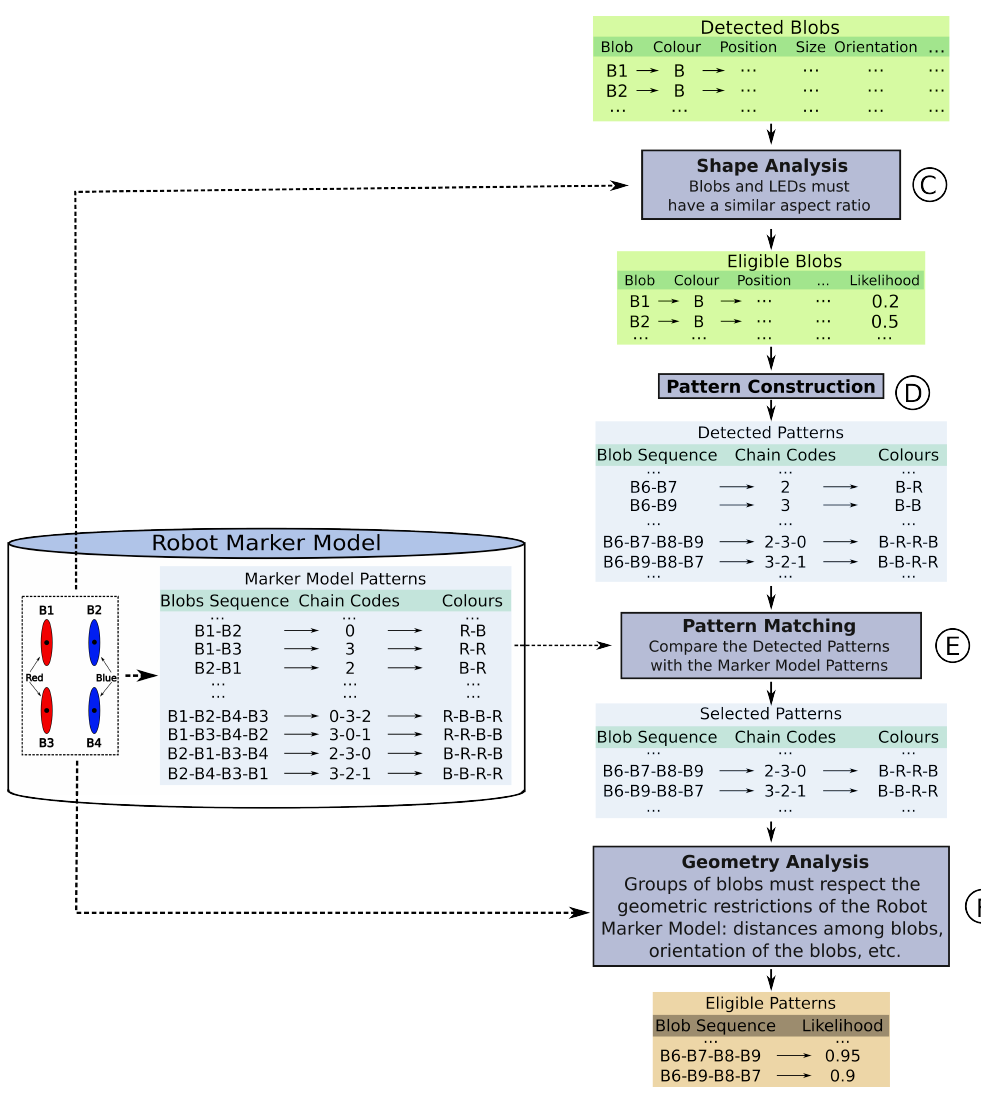
Figure 9. Stage 2: Robot’s Marker